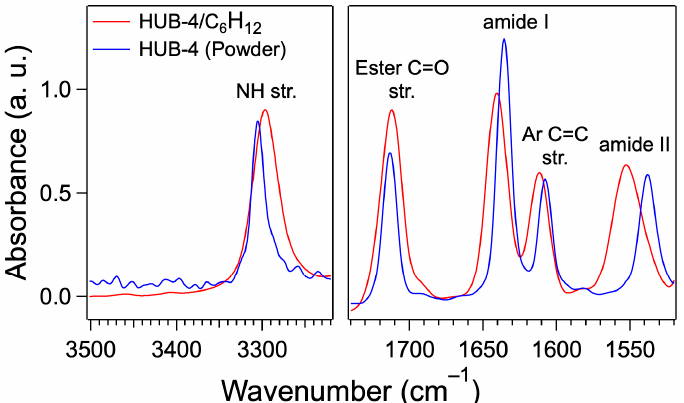
Figure 3. FTIR spectra of HUB-4/C 6 H 12 ( c = 4 wt.%) and pure HUB-4 (powder) in the NH and CO stretching area. In both samples the amide groups are H-bonded with each other, but with different